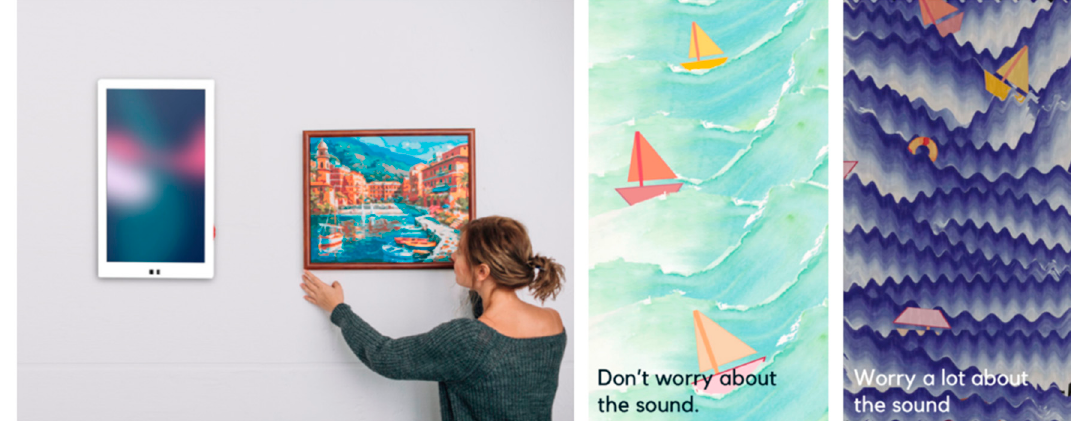
Figure 4. Doplor should function as a wall decoration and subtle tool to improve the noise problem of the critical care soundscape [40].